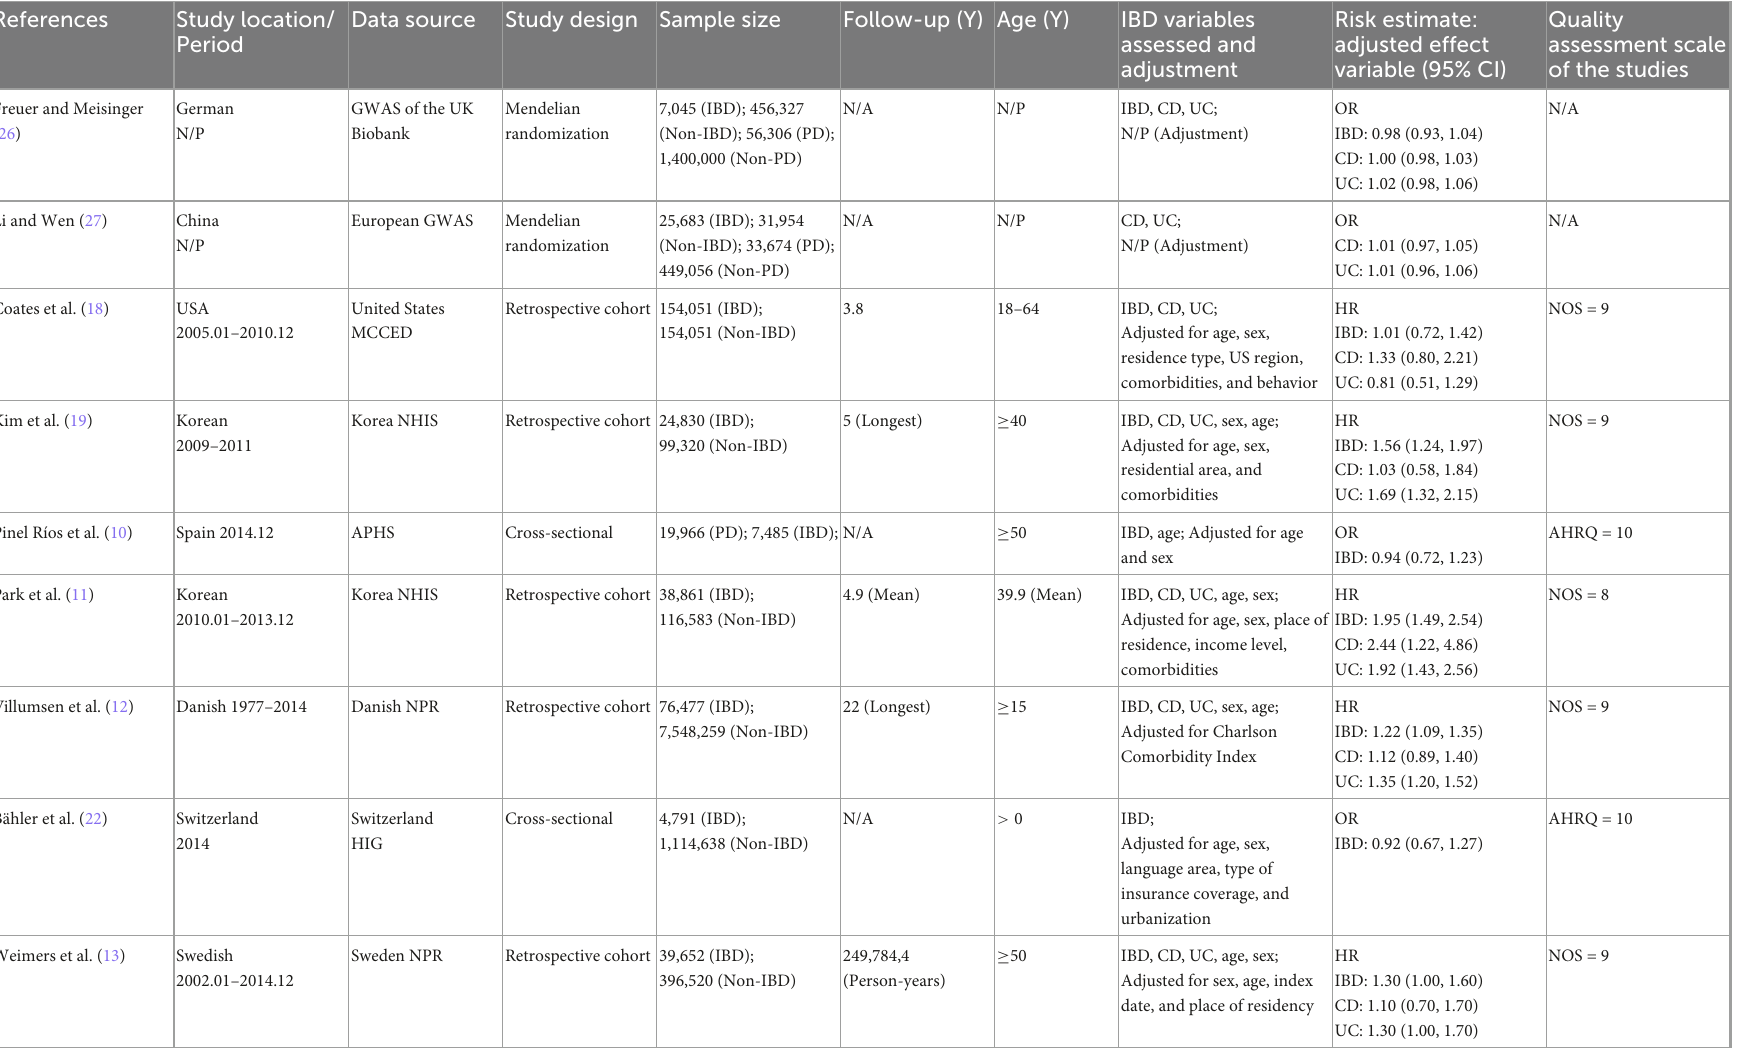
TABLE 1 Study characteristics of inflammatory bowel disease and the risk of Parkinson’s